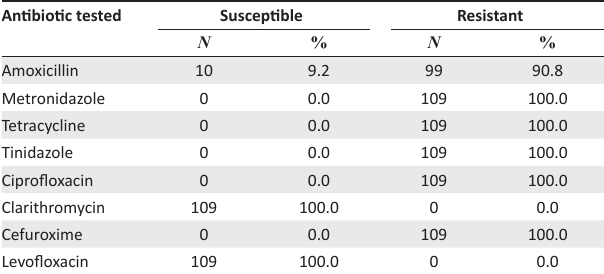
FIGURE 1: Helicobacter pylori in gastric biopsy at histology. TABLE 3: Helicobacter pylori antibiogram.